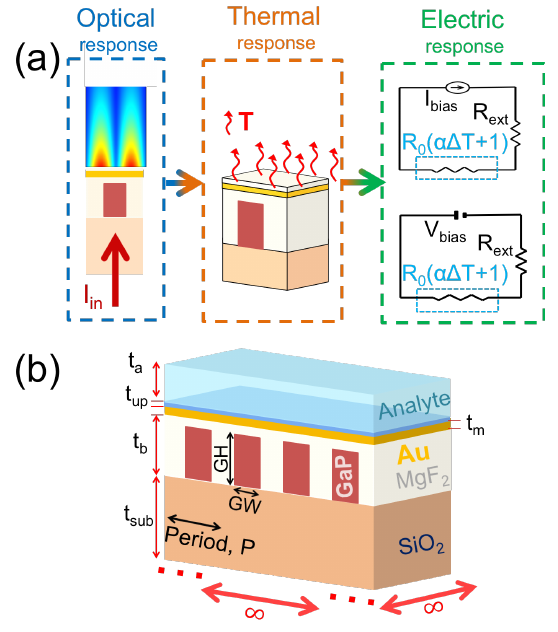
Figure 1. ( a ) Schematic representation of the physical phenomena (optical, thermal, and electronic responses) present in the proposed device. At the resonant wavelength, the excited plasmons (optical response) enhance absorption within the metal which increases its temperature (thermal